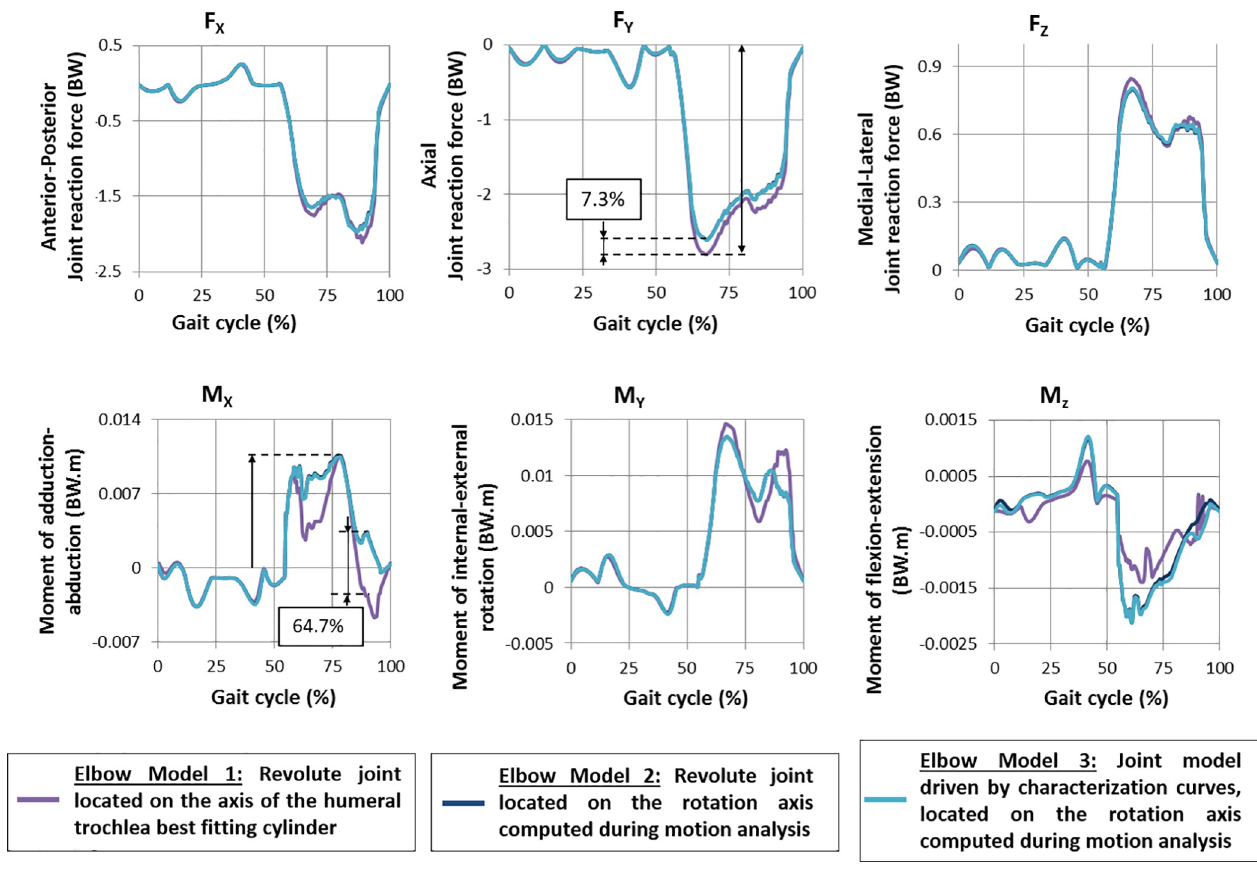
Fig 9. Simulated reaction forces at the